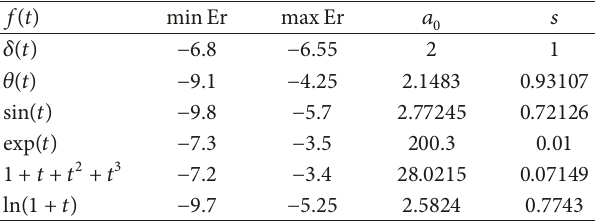
Table2:Minimalandmaximallogarithmicerrorsofapproximation for various source functions: hyperbolic